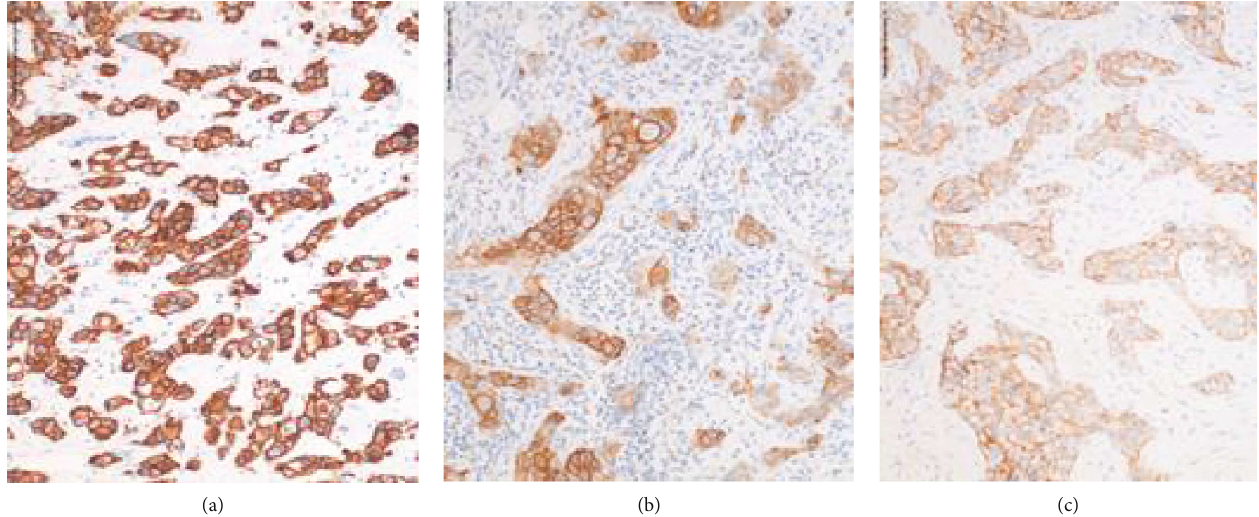
Figure 1: Patterns of HER2 IHC staining: (a) 100% HER2 IHC staining; (b) > 10% and < 100% HER2 IHC staining; (c) HER2 IHC 2+ staining.